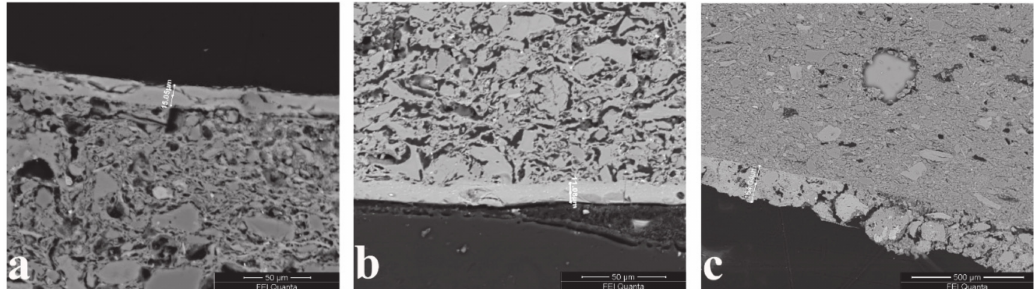
Figure 5. BSE images of slip and ceramic body of representative samples: ( a ) initial vitrification stage of ceramic body and homogeneous and compact slip (sample 4026-102); ( b ) extensive vitrification stage of ceramic body and homogeneous and compact slip (4032-104), ( c ) not vitrified body and porous slip (4226-108).